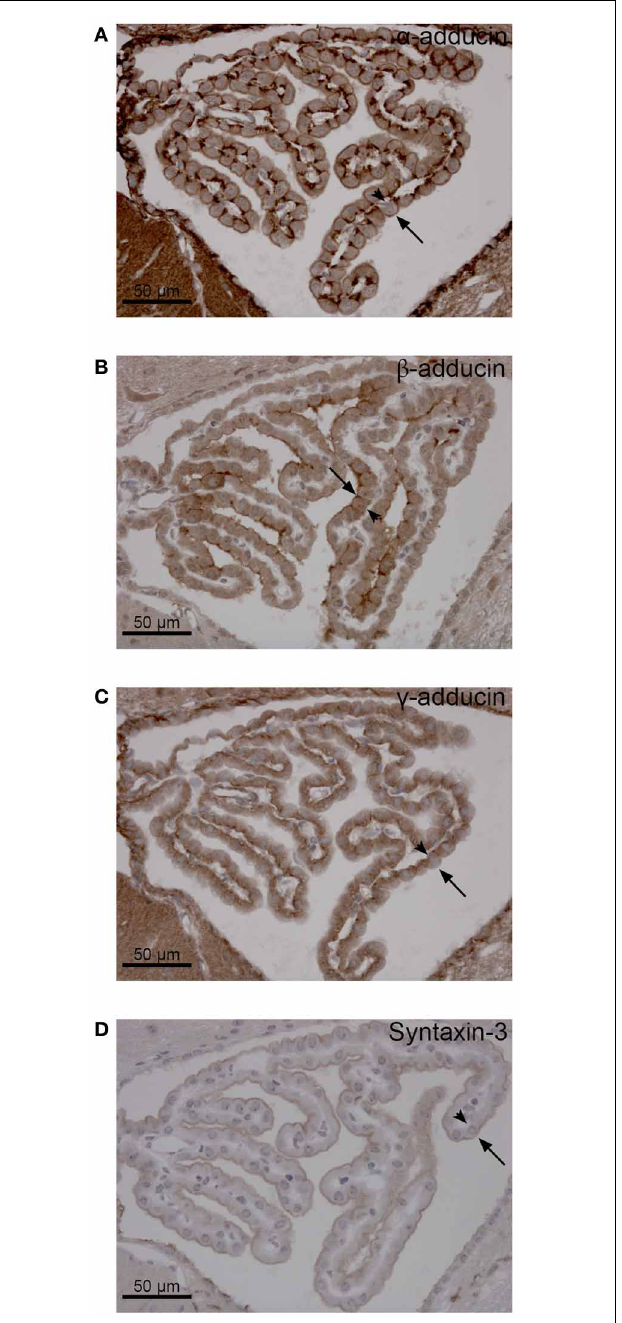
FIGURE 3 | Distribution of α -, β -, and γ -adducin in the mouse CPE. (A–C) Peroxidase immunohistochemical localization of α -, β -, and γ -adducin in the normal mouse CPE, as indicated. (D) Immunostaining of the normal mouse choroid plexus for syntaxin-3. Arrows indicate the luminal membrane, while arrowheads indicate the basolateral